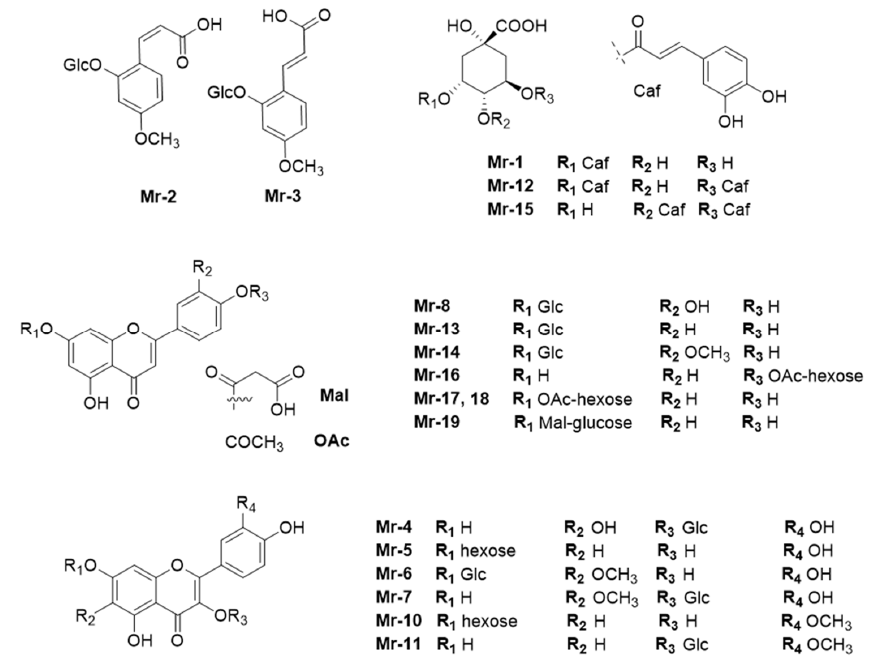
Figure 3. Constituents ( Mr ‐ 1 – Mr ‐ 19 ) detected in Matricaria recutita flowers.